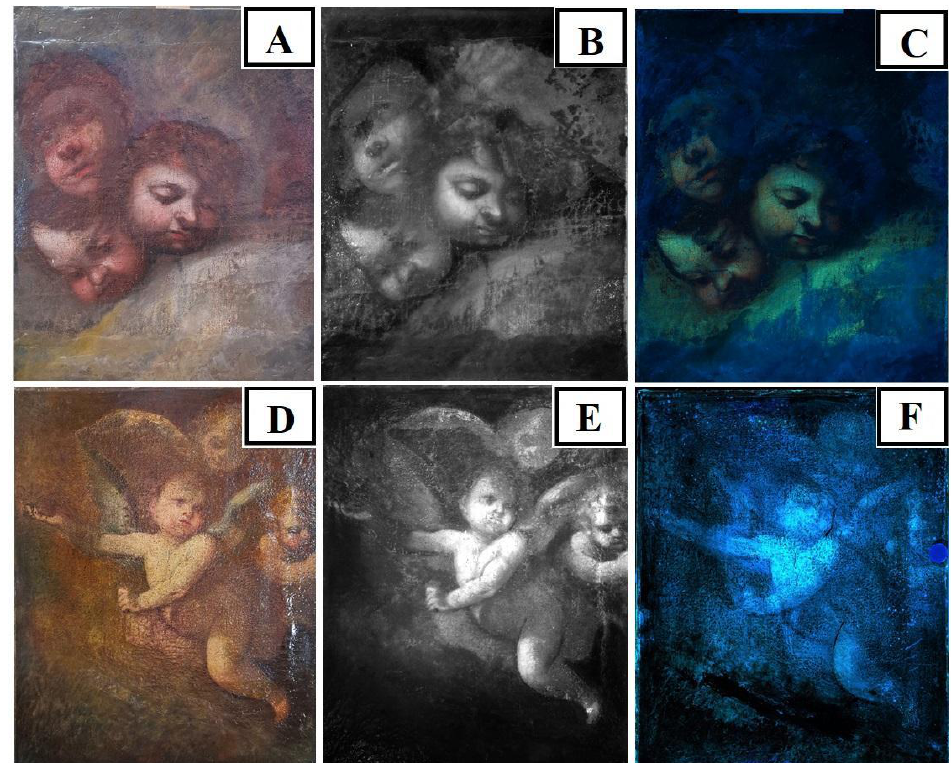
Figure 4. Photograph of Painting 1 and Painting 2 ( A , D ) and related 950 nm IR ( B , E ) and UV ( C , F ) images. In the IR images, the areas affected by repainting appear to be of a darker grey tone than the original pictorial layer of the same color in the visible range. The same pictorial areas appear devoid of visible fluorescence under a UV source (dark areas), confirming the mapping of pictorial retouchings overlapped onto the original surfaces.